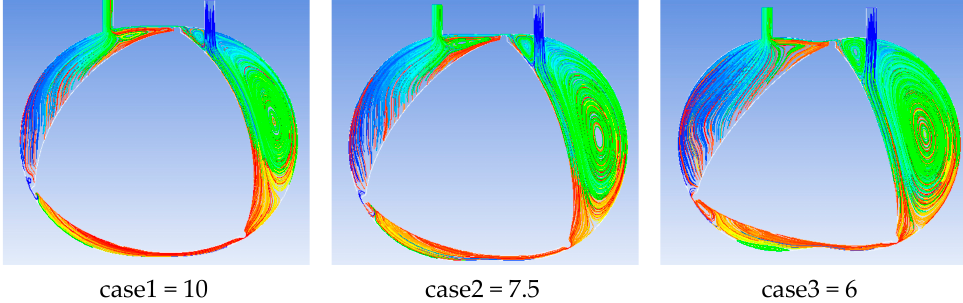
Figure 16. Stream lines of the three cases and vortex formation (Hsieh and Cheng [85]).